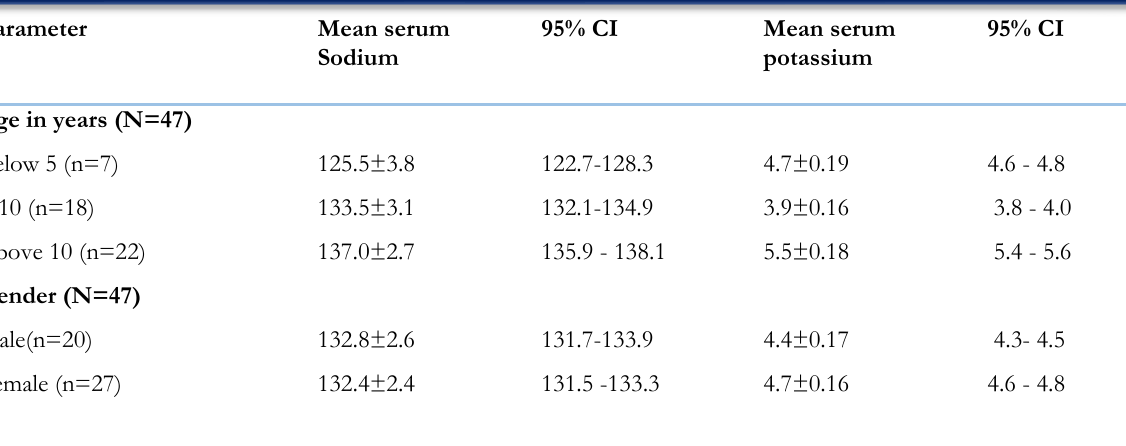
Table 2: Mean serum sodium and potassium concentrations according to age, gender and admission blood glucose